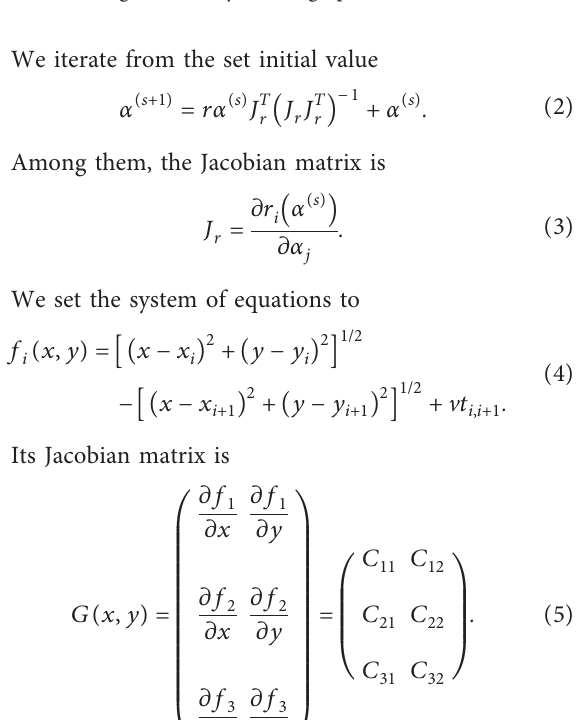
Figure 2: The calculation framework of fractal dimension values generated by fractal